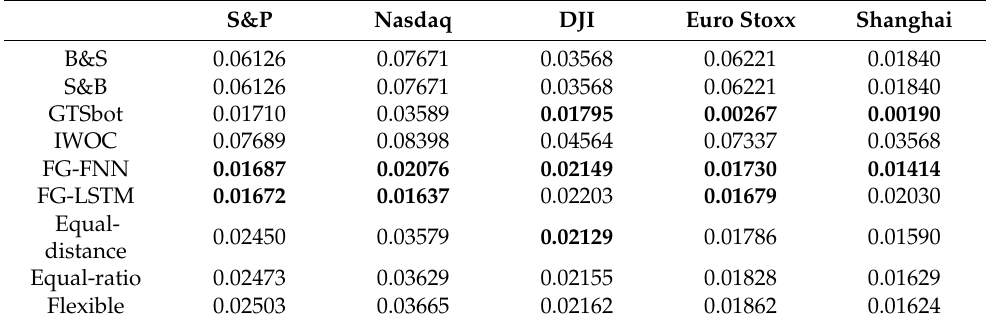
Table 18. Comparison of volatility.